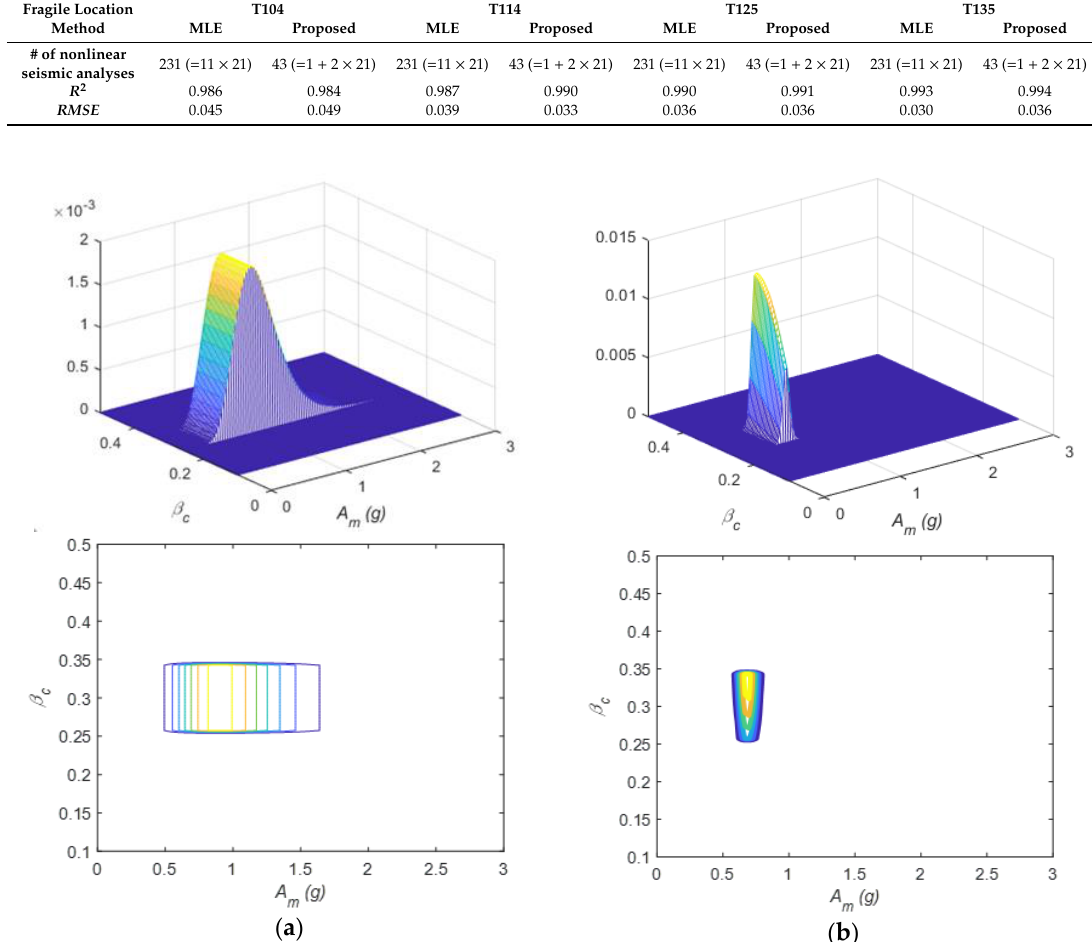
Table 1. Comparison of the accuracy and the numerical cost for the piping seismic fragility curves according to two methods, i.e., incremental dynamic analysis (IDA)-based maximum likelihood estimation (MLE) method and the proposed method (Bayesian approach with the EPRI SOV method).